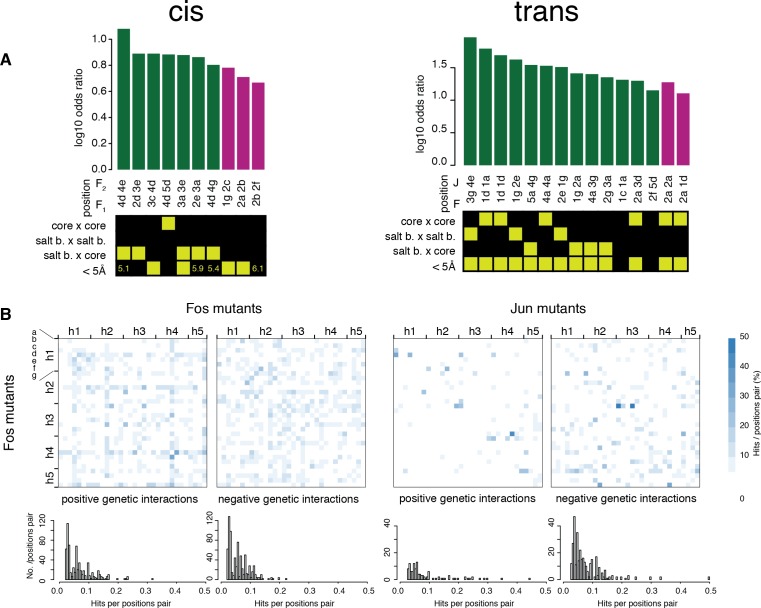
Comparisons of the pairs of positions enriched in cis and trans.(A) Pairs of positions significantly enriched in positive (green) or negative (purple) genetic interactions (Fisher’s exact test, FDR = 10%). Each pair of positions is also classified according to its heptad position type and the distance between the two positions (bottom matrix, yellow cells). (B) Heatmap (top) and distribution (bottom) of percentage of significantly positive (left) or negative (right) genetic interactions per pairs of position. The trans data analyzed here is restricted to amino acid substitutions reachable through single nucleotide changes.